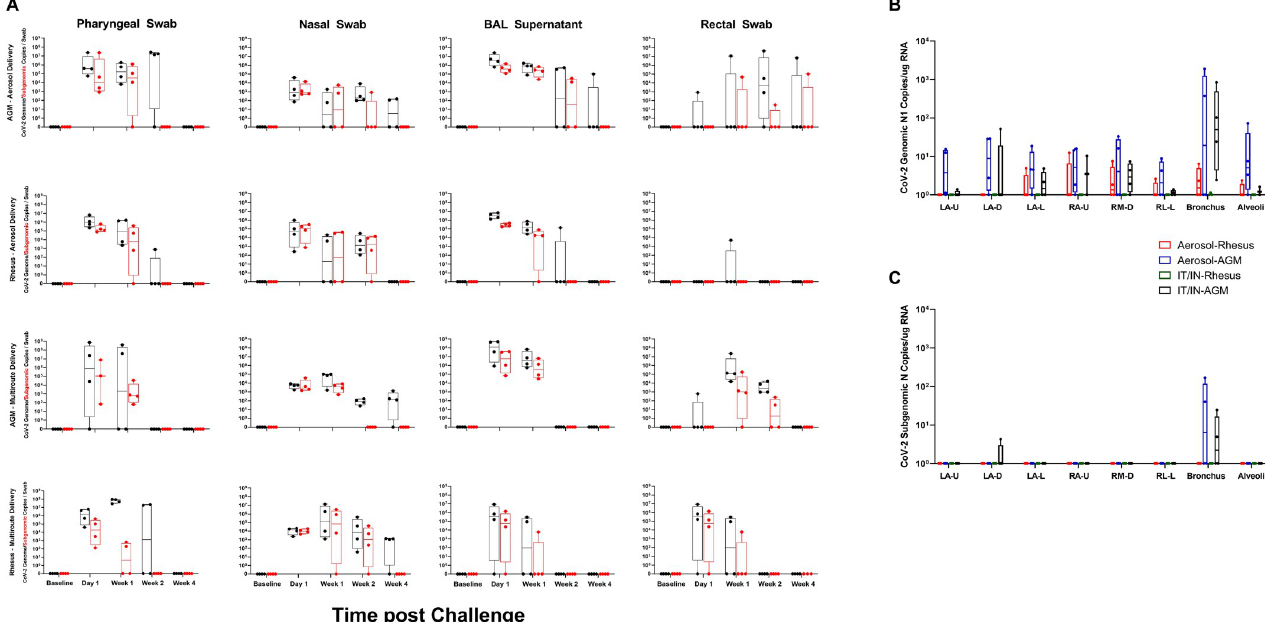
Fig 2. Viral Loads Assessed via RT-qPCR post SARS-CoV-2 Challenge. A)Viral loads in swabs and BAL supernatant were assessed via RT-qPCR post challenge for genomic (black) and subgenomic N (red) RNA. After necropsy, respiratory tissues were analyzed for the presence of genomic (B) and subgenomic (C)